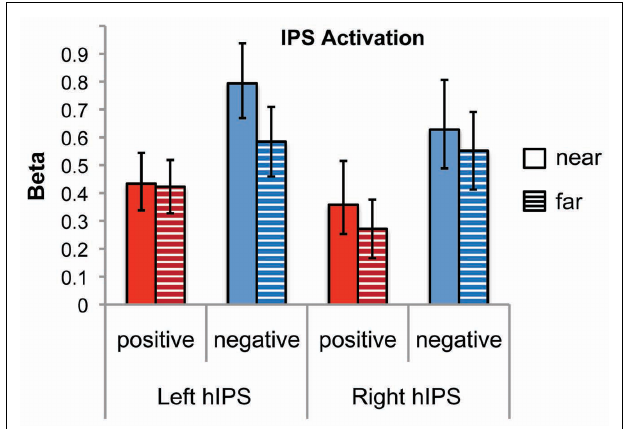
FIGURE 6 | Distance effects in cyto-architectonic maps of the intraparietal sulcus (IPS). There was significant activation for both number types and both distances in the left and the right IPS (combining hIP1, hIP2, and hIP3).There was a significant number type by distance by hemisphere interaction ( p = 0.028).The left IPS showed a marginally significant effect of distance for negative numbers ( p = 0.059) but not for positive numbers. Neither number type showed a distance effect in the right IPS.